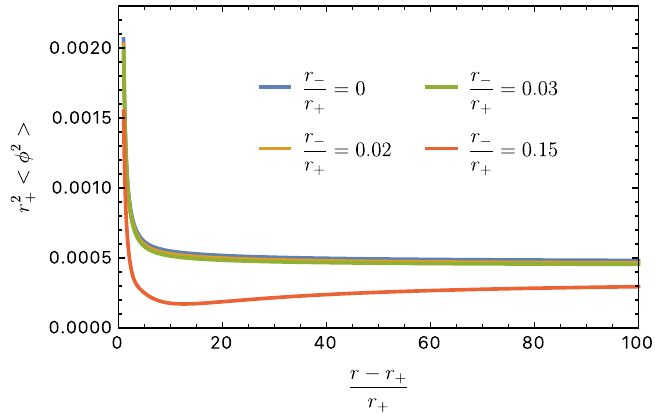
Figure 4 . Pro(cid:12)le of the vacuum polarization h (cid:30) 2 i as a function of the radius r . Speci(cid:12)cally, it is ren plotted r 2 h (cid:30) 2 i in terms of r (cid:0) r + for (cid:21) = 7 : 1 (cid:2) 10 (cid:0) 3 , r + (cid:22) = 0 : 01 for several values of r (cid:0) , namely + ren r + r + r (cid:0) = 0 ; 0 : 02 ; 0 : 03 ; 0 : 15. The case r (cid:0) = 0 is the Schwarzschild case and r (cid:0) = 0 : 02 ; 0 : 03 ; 0 : 15 are r + r + r + typical Reissner-Nordstr(cid:127)om cases. The extremal case r (cid:0) = 1, not shown, gives h (cid:30) 2 i = 0 for all ren r + r (cid:0) r + as can be inferred from the plots, i.e., there is no vacuum polarization for extremal black holes. r +